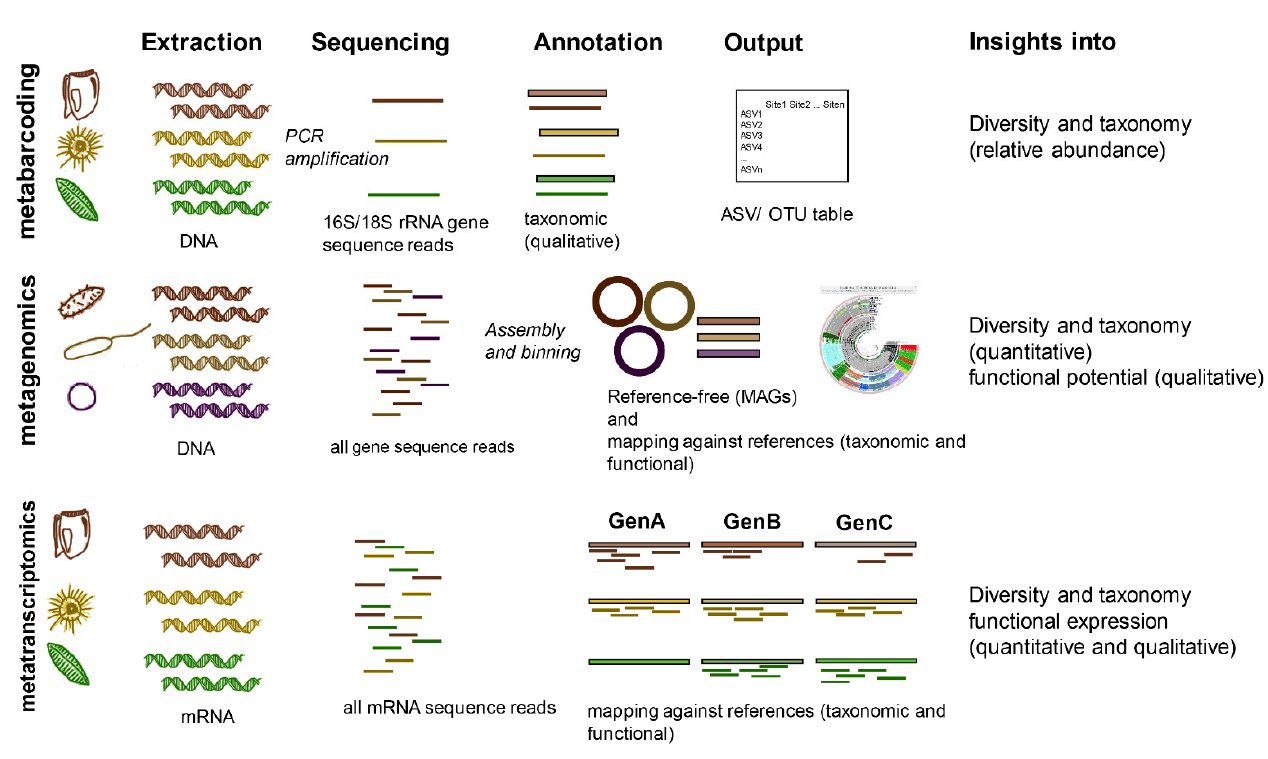
Figure 2. Schematic workflow and output of metabarcoding, metagenomics, and metatranscriptomics. Metagenomic output reflects potential visualization using the anvio